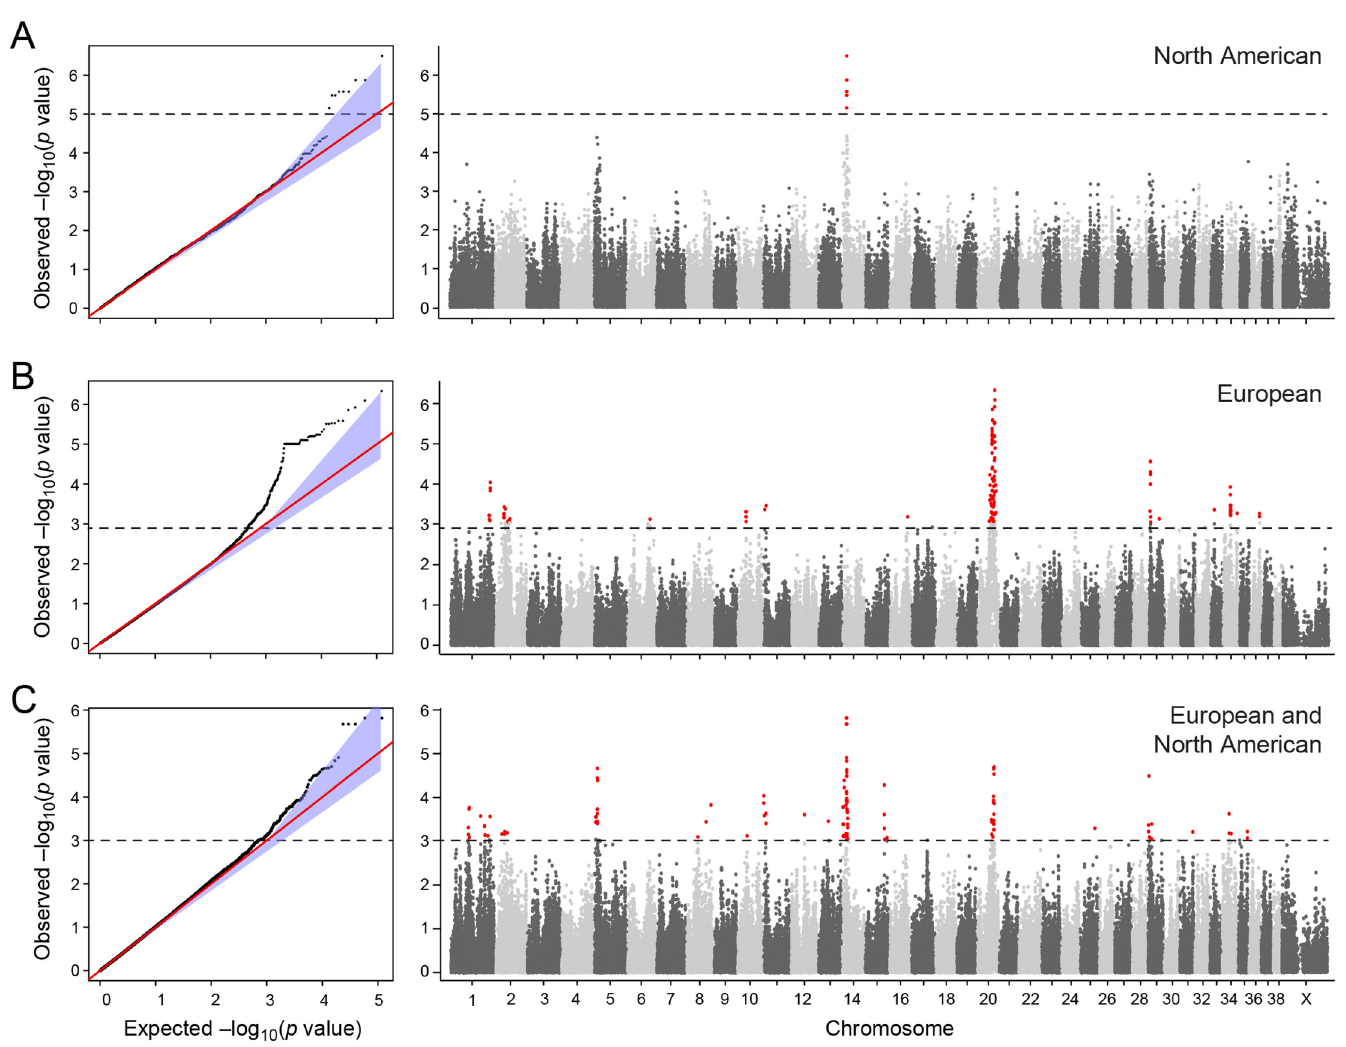
Fig 2. Manhattan plot showing the – log 10 p-values in relation to the chromosomes. a) American data b) European data c) American and European data combined. Q-Q plots showing the expected p-value in relation to the observed p-value for each GWAS analysis. Shaded area indicates 95% confidence interval. Stippled line marks nominal significance